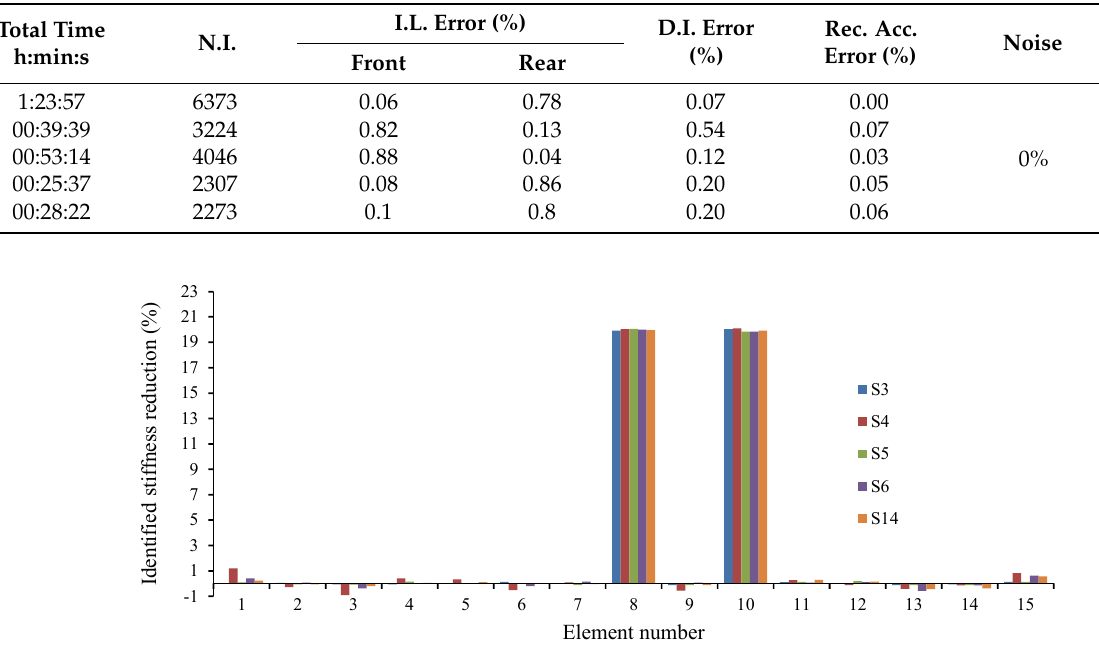
Table 6. The results obtained from different sensor placements.